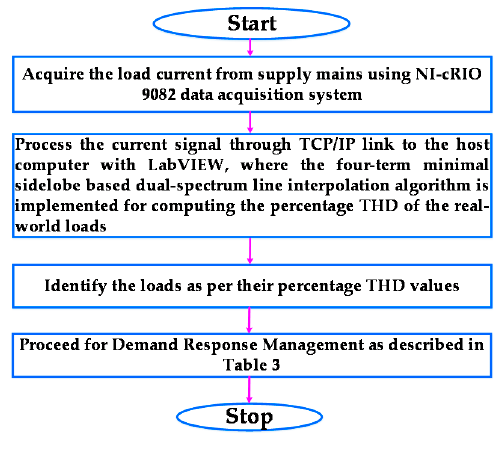
Figure 4. Flow chart for percentage THD computation.